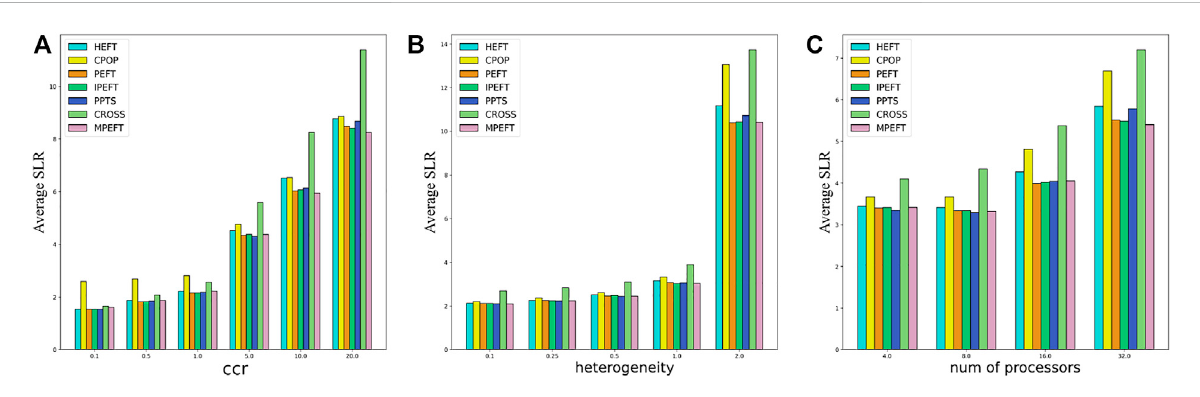
FIGURE 14 Average SLR as function of ccr (A) , heterogeneity (B) and number of processors (C) for Gaussian Elimination Work fl